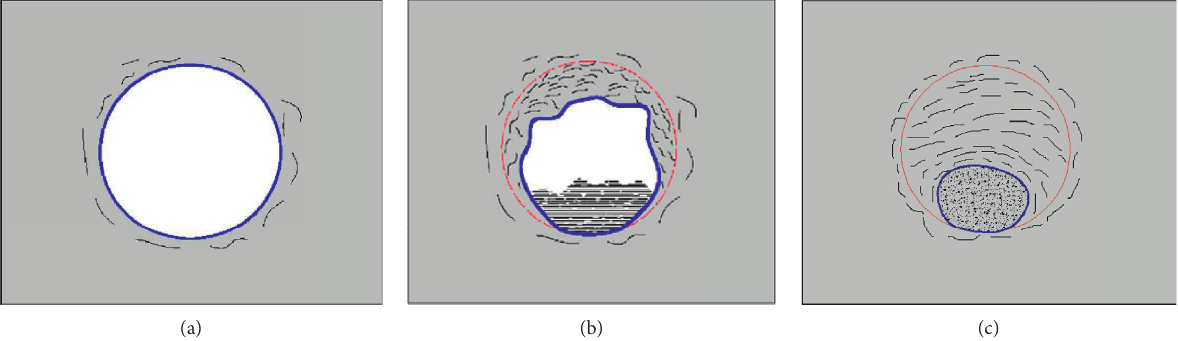
′ , borehole radius after instability; U , 0